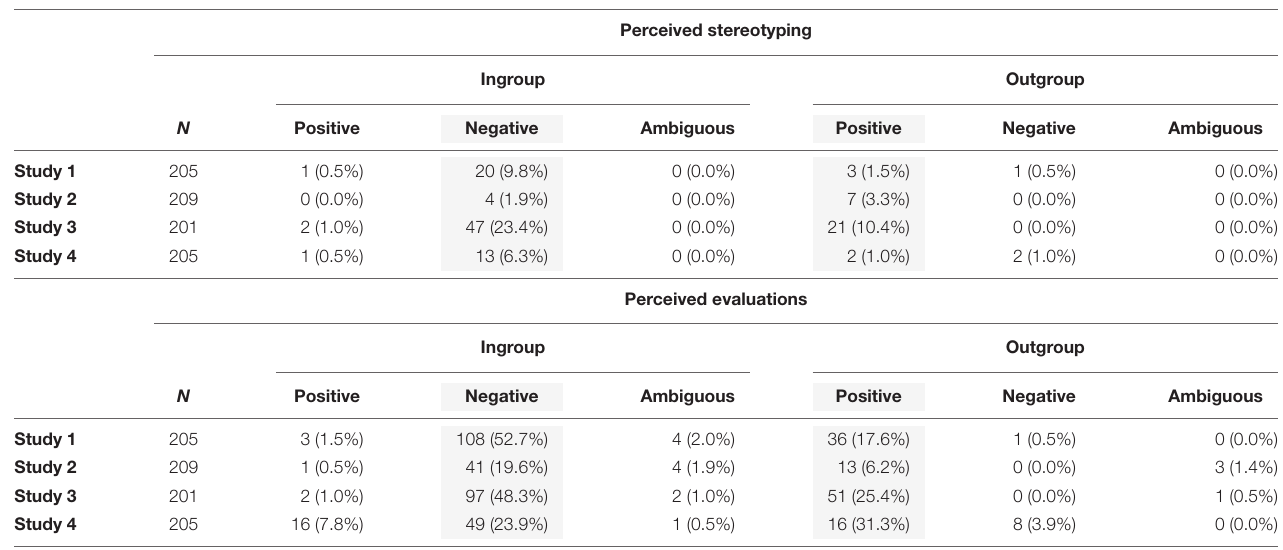
TABLE 3 | Frequency of perceived stereotyping and group